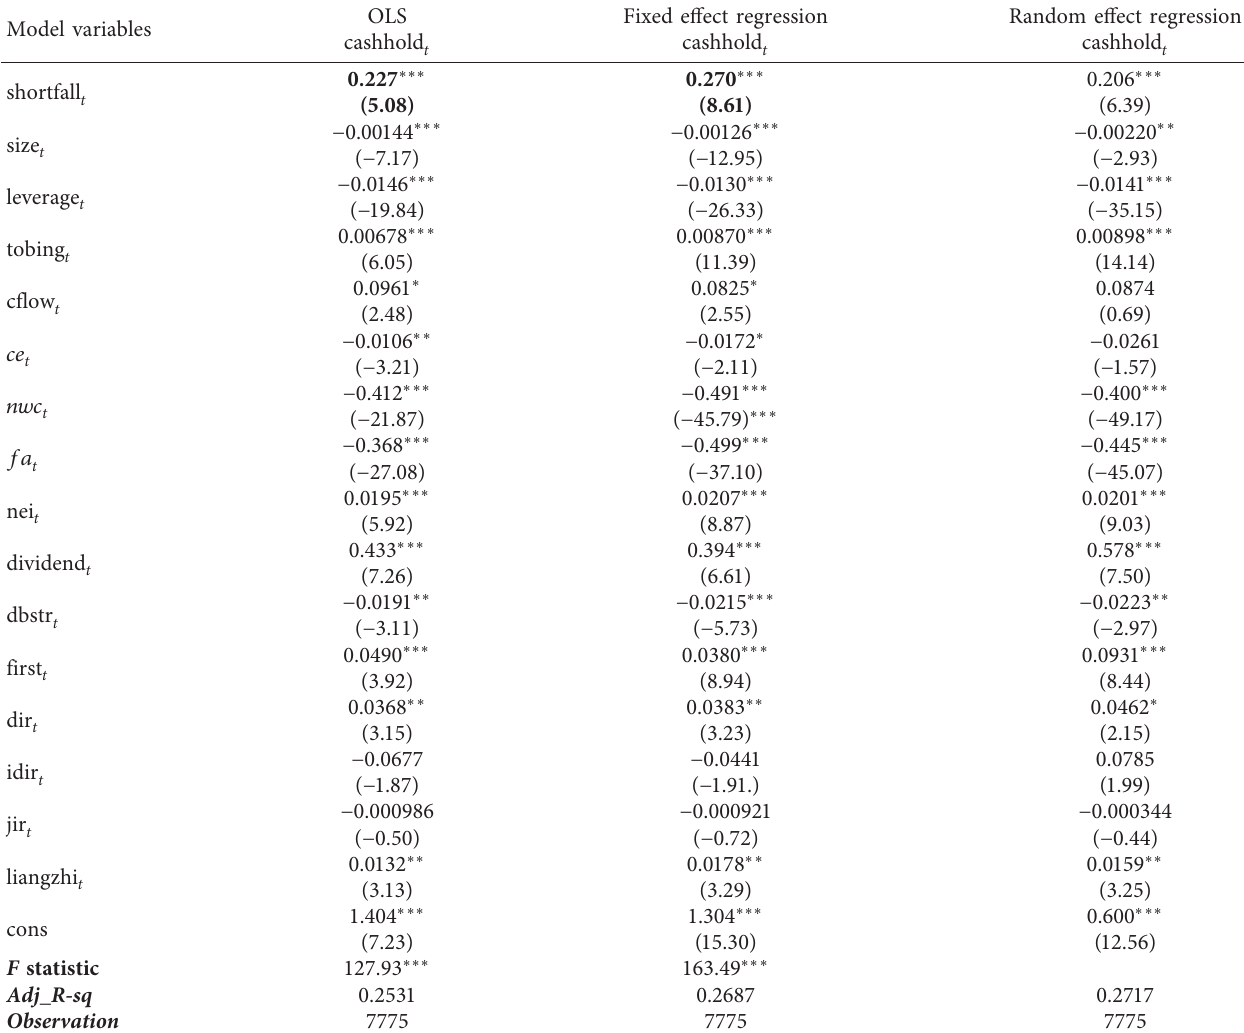
Table 4: The regression result of validating Hypothesis 1.